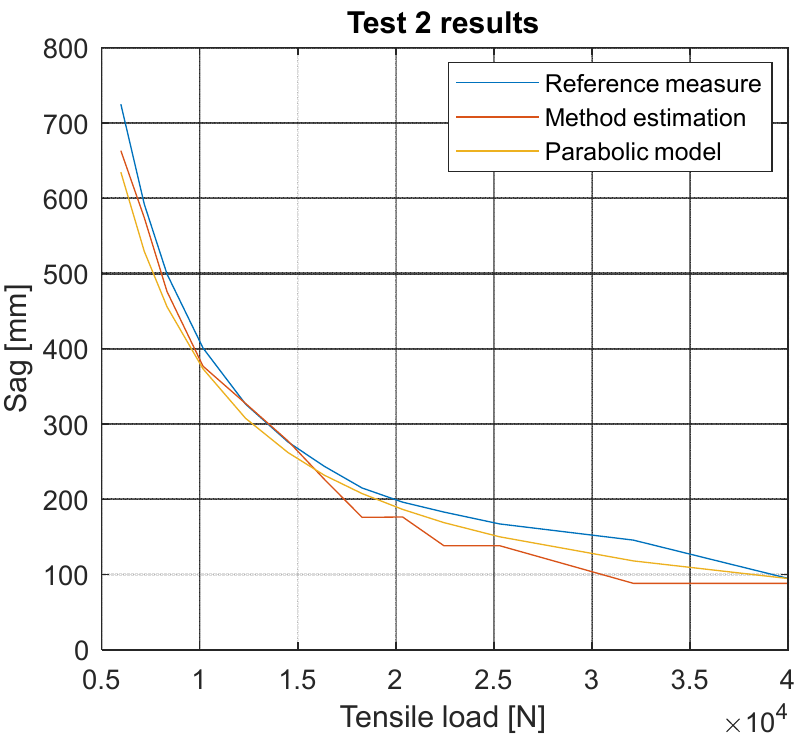
Figure 8. Comparison of the sag values estimated through the proposed method (red curve) with the reference measured values (blue curve) and the ones from the parabolic model (yellow curve) during Test 2.